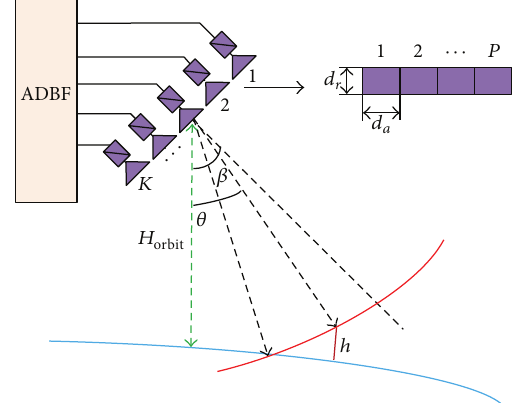
Figure 2: Geometry of HRWS SAR elevation adaptive